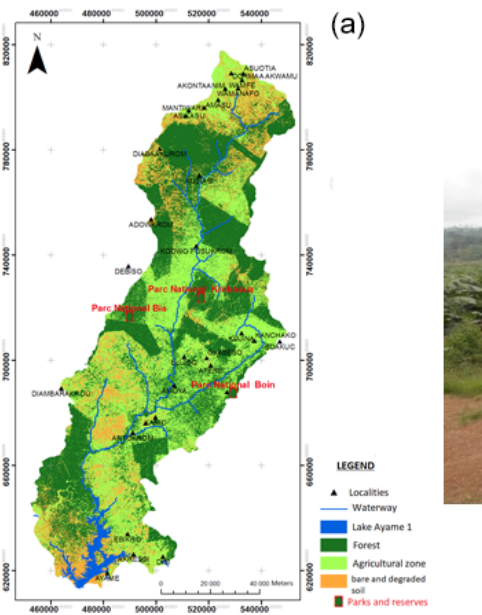
Figure 2. (a) Land cover and (b) land use of the Bia